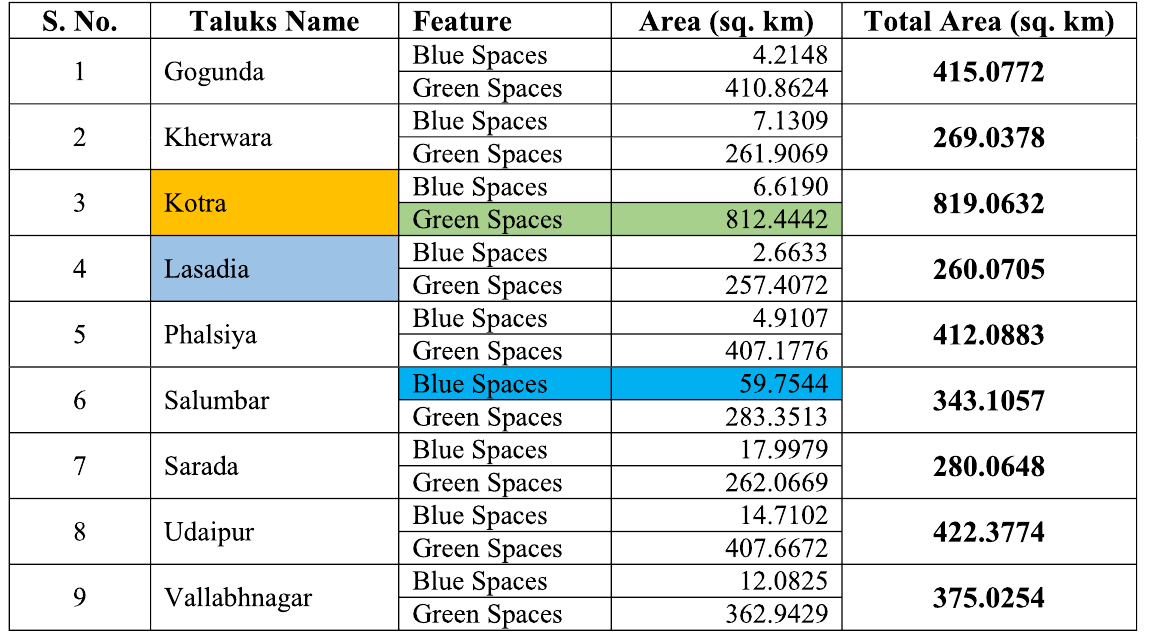
Table 8 Summary of green and blue spaces across the